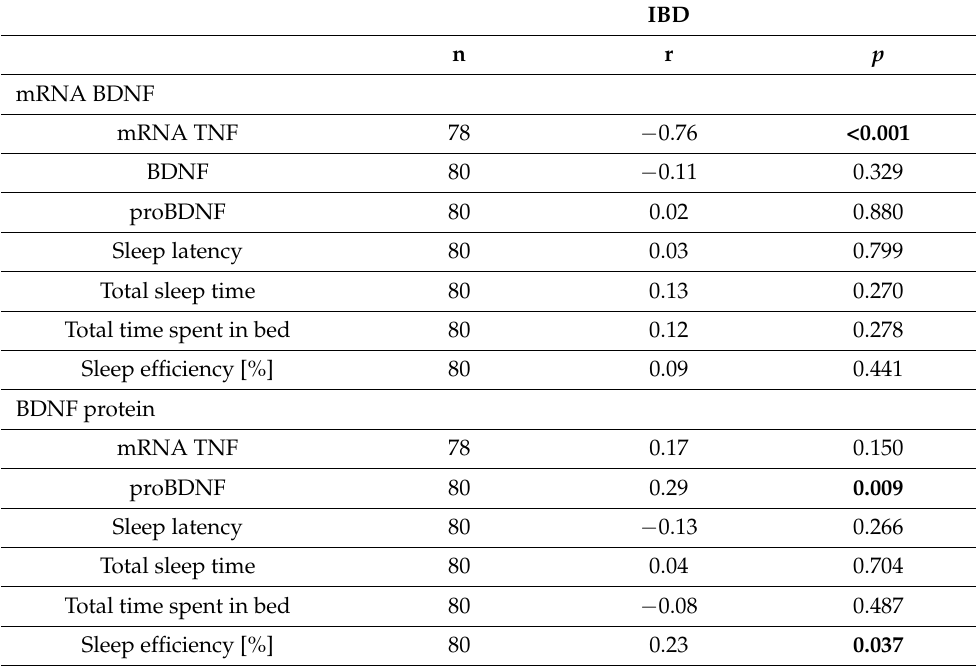
Table 3. Correlations between level of expression of studied neurotrophins and selected sleep pa- rameters.